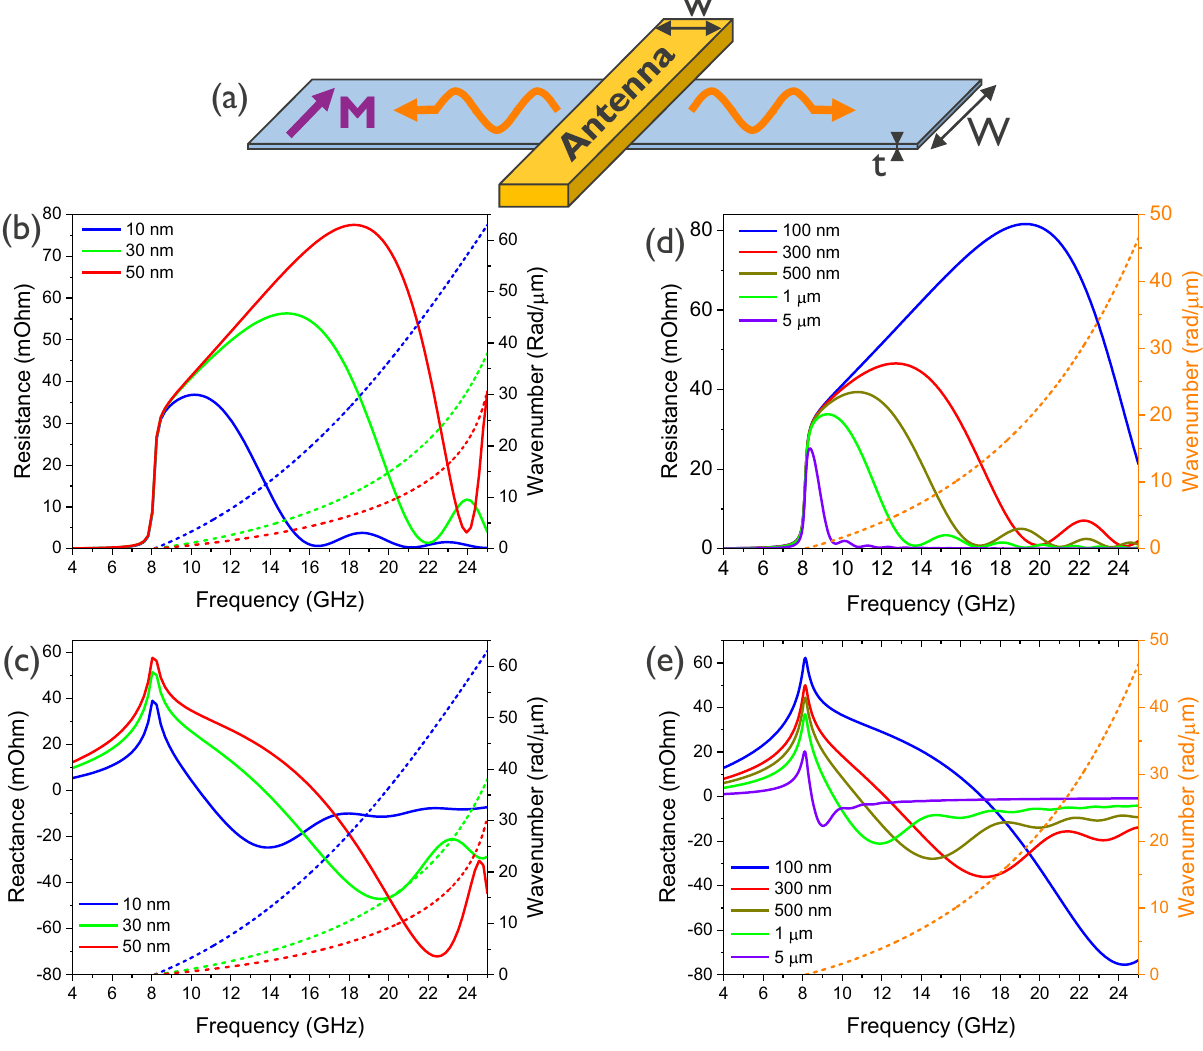
Figure 4. Dependence of the spin-wave impedance on the frequency f in the (a) Damon–Eshbach configuration for different geometrical antenna and waveguide parameters. (b) Dependence of the spin-wave resistance and (c) spin-wave reactance on the magnetic waveguide thickness t ( W = 1 µ m , w = 300 nm). (d) Dependence of the spin-wave resistance and (e) spin-wave reactance on the antenna width w ( W = 1 µ m , t = 30nm ). The FMR frequency is located at zero wavenumber, i.e. at a frequency of 8.1 GHz for the parameters